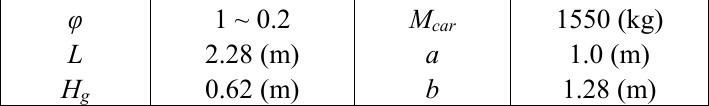
Table 2. LF620EV Parameters used for studying the proposed RBS.